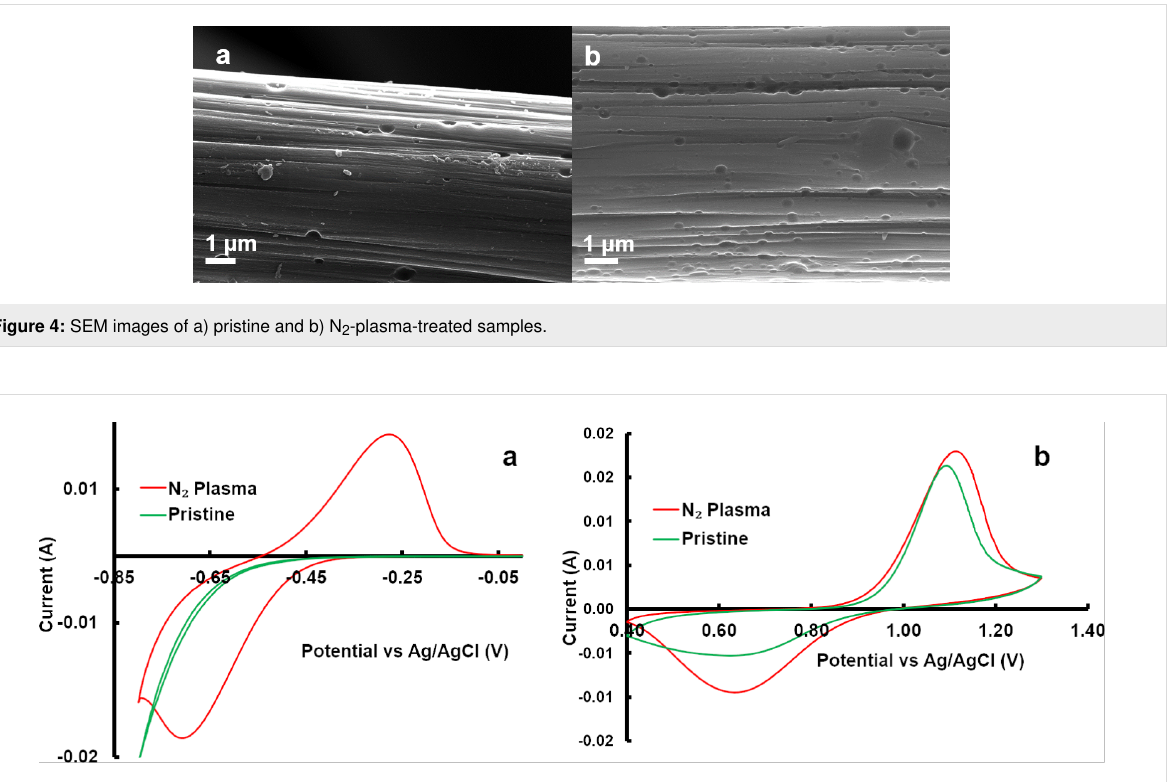
Figure 5: CV curves obtained for the pristine and the N 2 -plasma-treated sample: a) negative redox reaction, b) positive redox reaction.